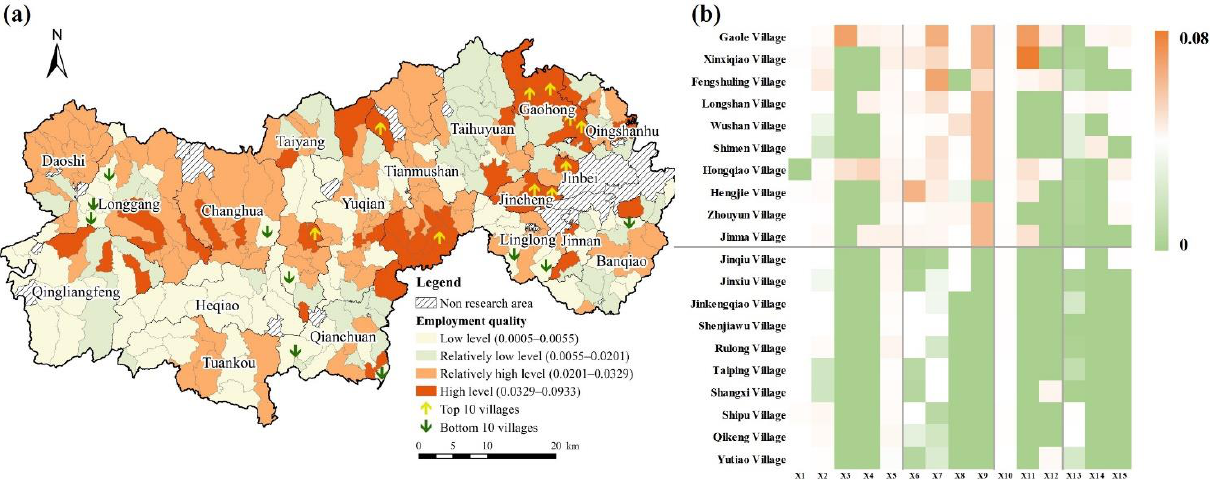
Figure 6. Performance of employment quality in Lin’an District. ( a ) Employment context index. ( b ) Top 10 villages and bottom 10 villages.